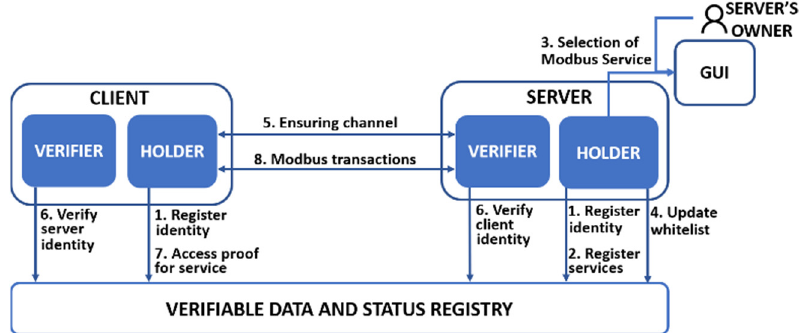
Figure 1. Overview of